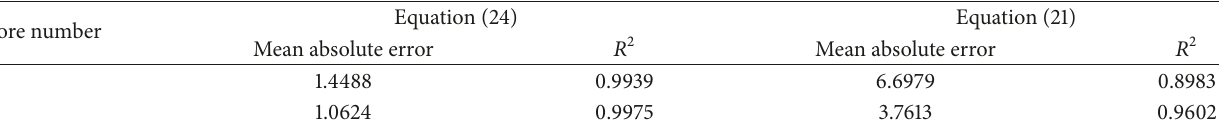
Table 2: Calculation result contrast of the different equations.